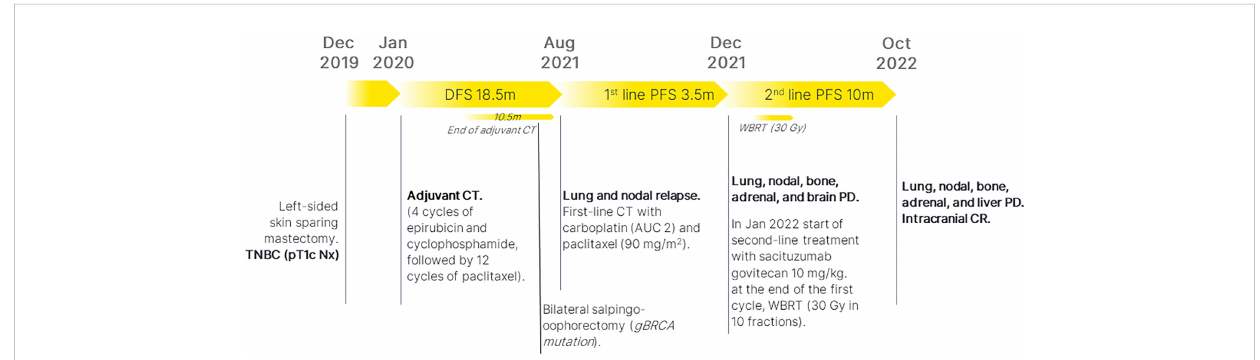
FIGURE 1 Patient ’ s timeline. TNBC, triple-negative breast cancer; CT, chemotherapy; DFS, disease-free survival; PFS, progression-free survival; PD, progressive disease; CR, complete response; WBRT, whole-brain radiotherapy; m,